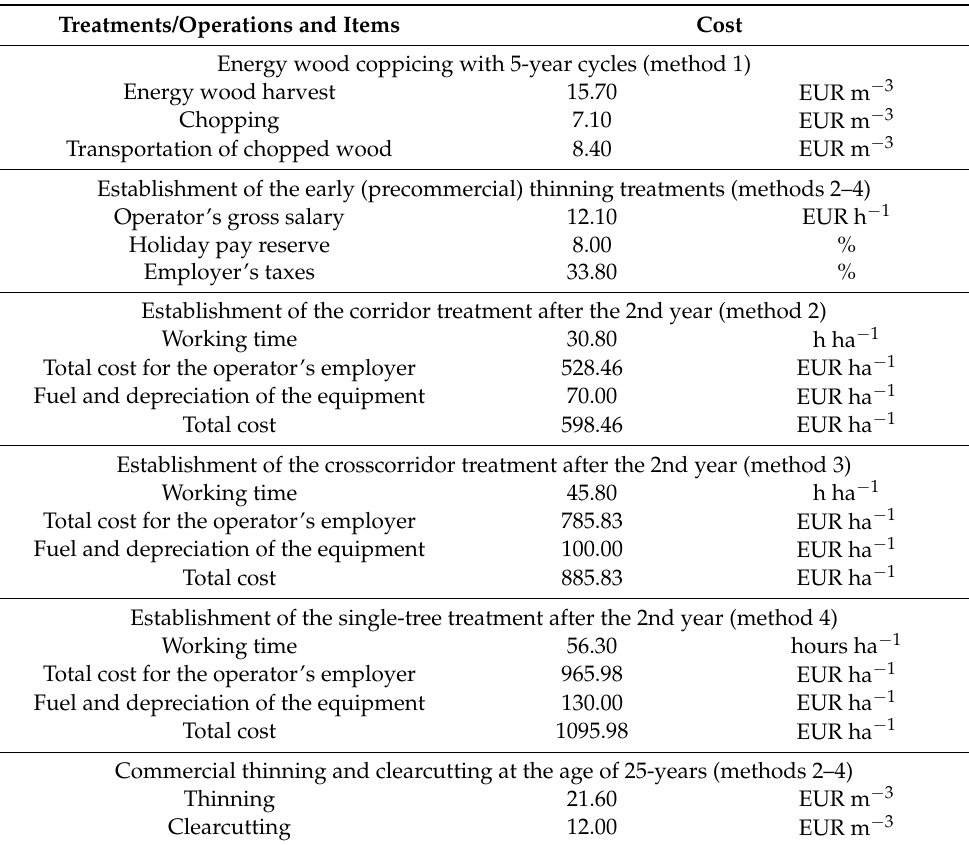
Table 3. Operating costs related to different management